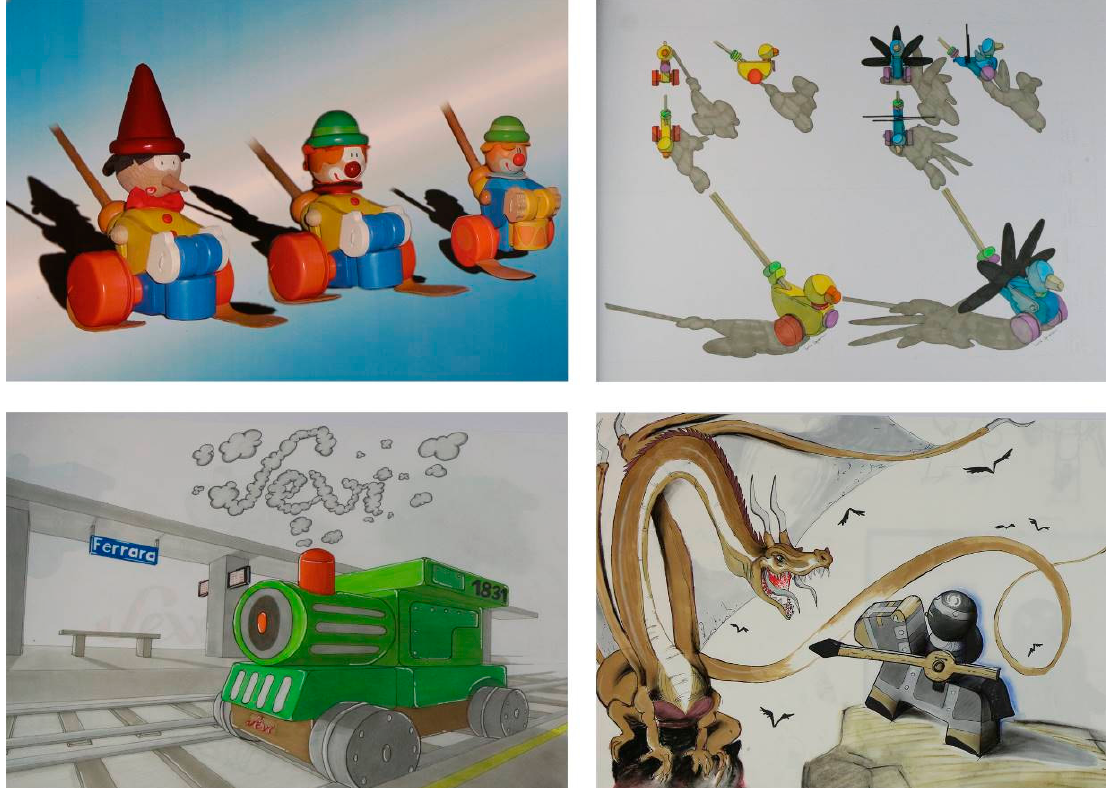
Figure 6. Hand drawing concepts by students representing the toys’ metamorphosis in imaginary